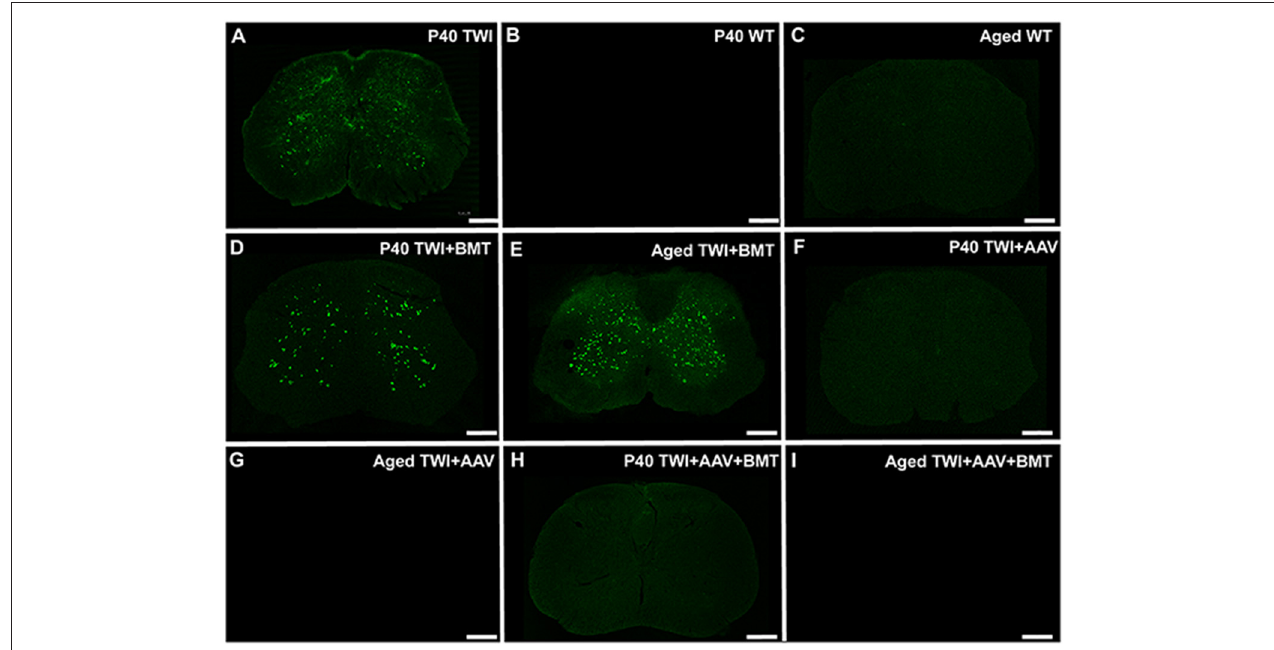
FIGURE 6 | Thioflavin-S positive inclusions are prevented with AAV-GALC gene therapy but not bone marrow transplantation. The extent of thio-S positive inclusions in the TWI (A) spinal cord, was not significantly improved with bone marrow transplantation (BMT) at either a P40 (D) or an aged (85 days of age) (E) timepoint. Treatment with AAV gene therapy either alone (F,G) or in combination with BMT (H,I) prevented the development of thio-S inclusions at both an early (P40) and late (aged, 350–550 days of age) timepoint. The staining present in the AAV and AAV + BMT treated TWI was comparable to WT mice at the same timepoints (B,C) . Observations present in n = 3 animals for all groups except aged TWI-AAV which n = 2. Scale bars represent